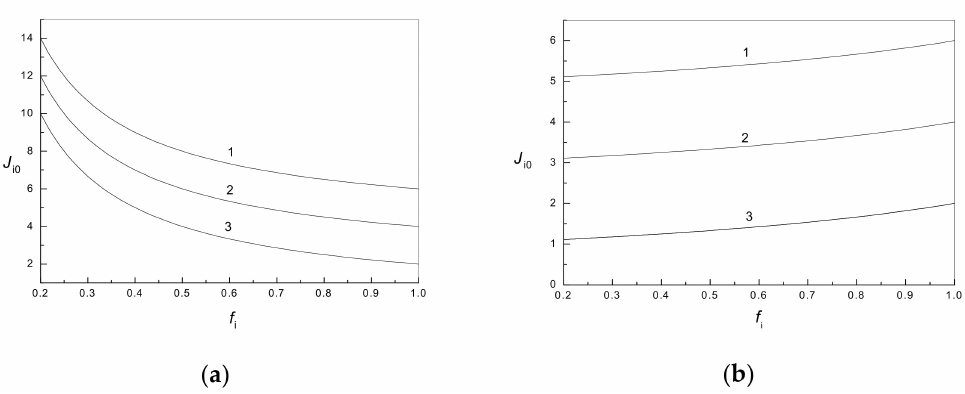
Figure 1. Dependence of J i0 on f i for di ff erent values of parameter γ i = 1: γ i = 5, 2: γ i = 3, 3: γ i = 1; ( a ) A di ff usion-specular scheme of gas molecule scattering; ( b ) A backscattering scheme for gas